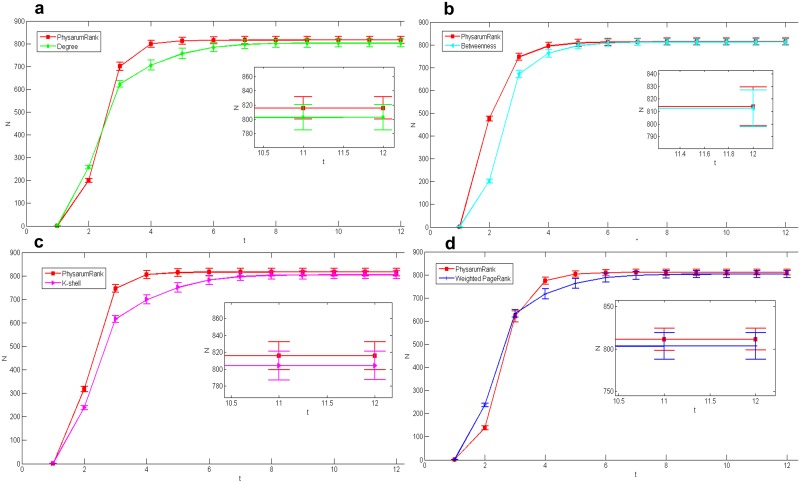
Comparison of epidemic spreading efficiency among different measures when L = 50, in US airports network.Each result N is obtained by averaging over 100 implementations with α = 0.2 and β = 1. (a):PhysarumSpreader vs Degree, n = 24. (b):PhysarumSpreader vs Betweenness, n = 35. (c):PhysarumSpreader vs K-shell, n = 27. (d):PhysarumSpreader vs Weighted PageRank, n = 18.